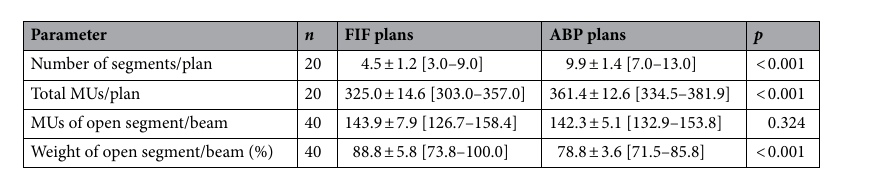
Figure 3. Comparison of dose-volume histograms of bilateral lungs among FIF plans and ABP plans. FIF, field- in-field technique; ABP, automated breast planning.